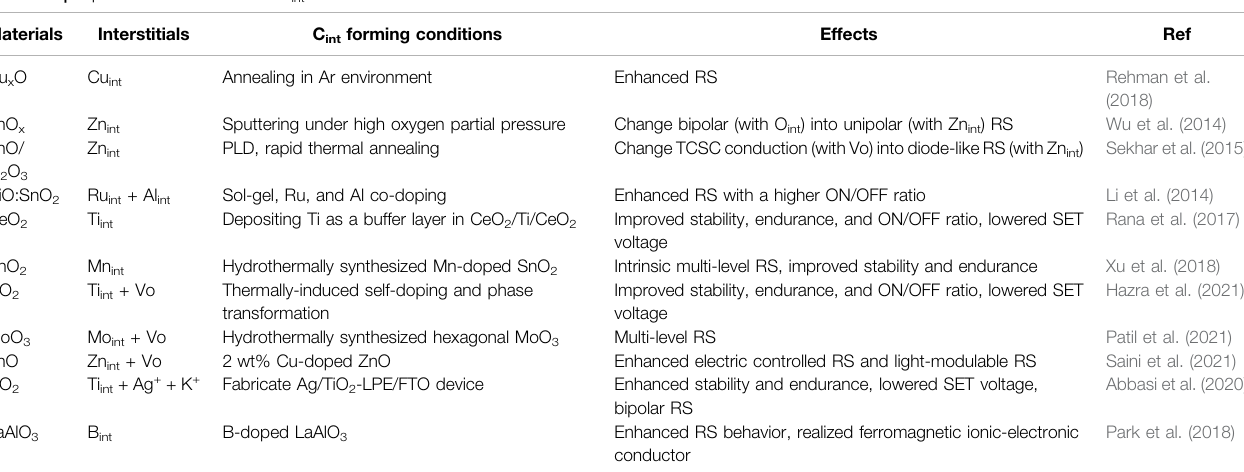
TABLE 2 | Experimental works on the C int -induced RS